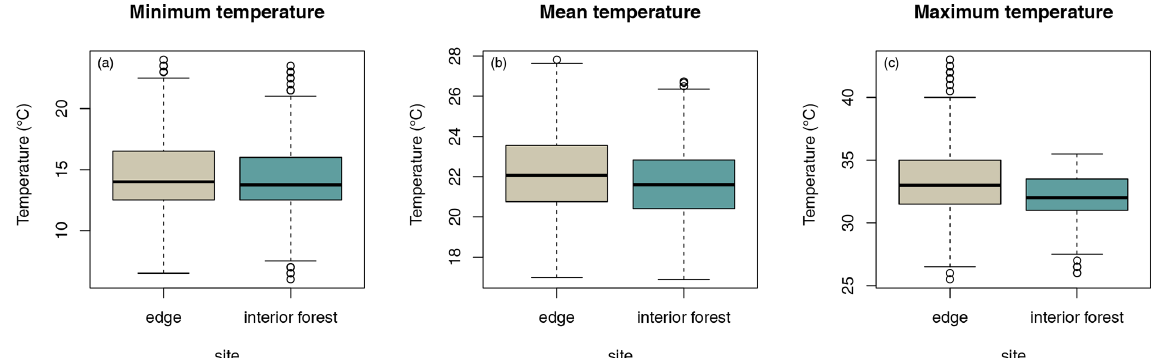
Figure 2. Differences in daily (a) minimum, (b) mean, and (c) maximum temperatures between